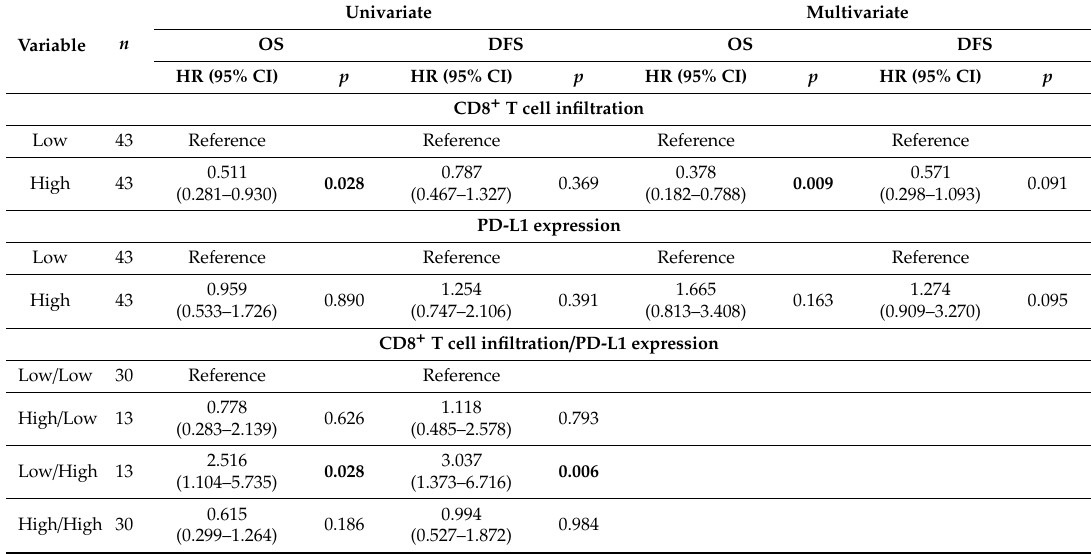
Table 1. Univariate and multivariate analysis of CD8 + T cell infiltration and PD-L1 expression for overall and disease-free